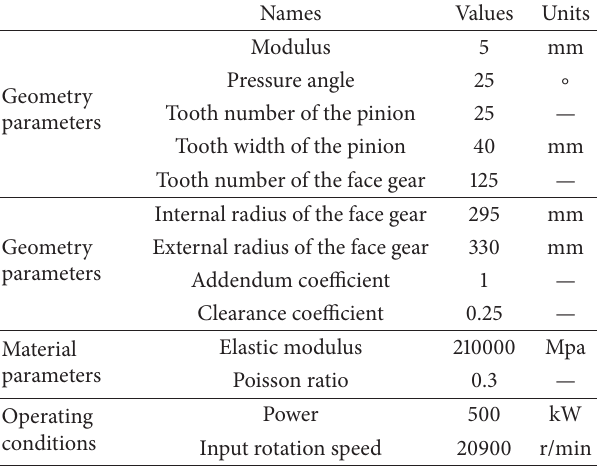
Figure 4: A sketch of STE of equivalent face gear drives. meshing error caused by manufacture and alignment errors of face gear drives.